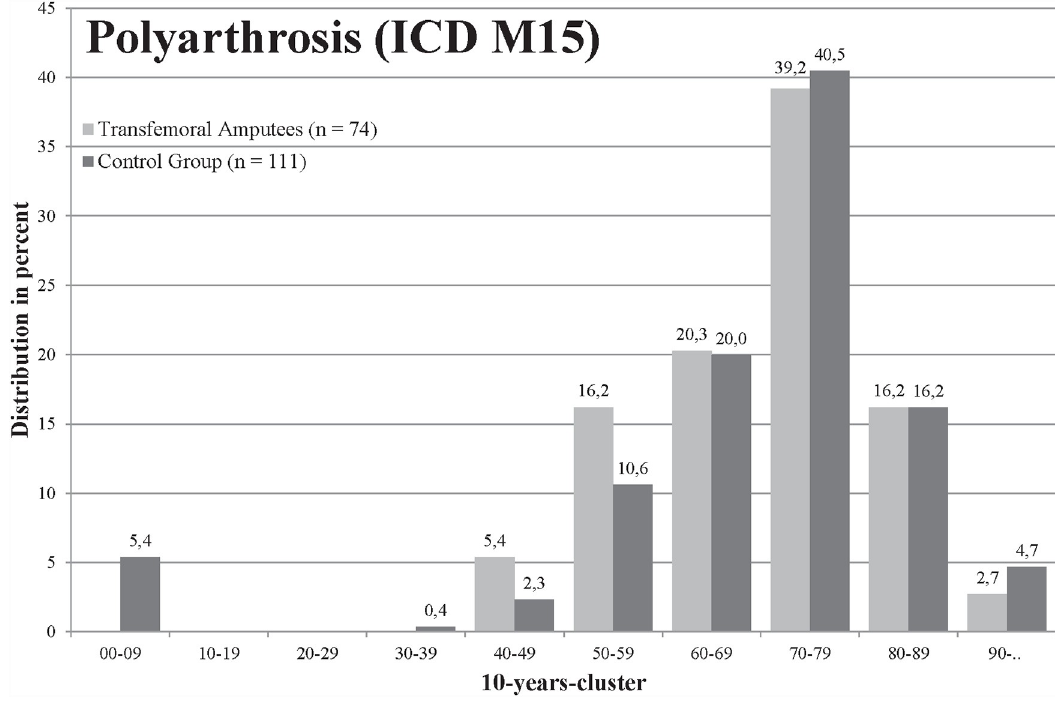
Fig 2. Age distribution of patients diagnosed with polyarthrosis (ICD M15). Amputee (light grey) and control group (black).